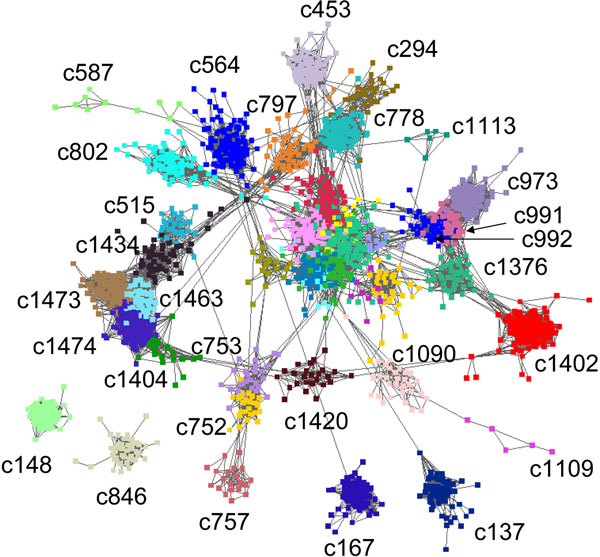
Gene co-expression subnetwork of Arabidopsis. Subnetwork contains genes in the top 40 functional modules with the highest statistical significance of enrichment of Gene Ontology terms.